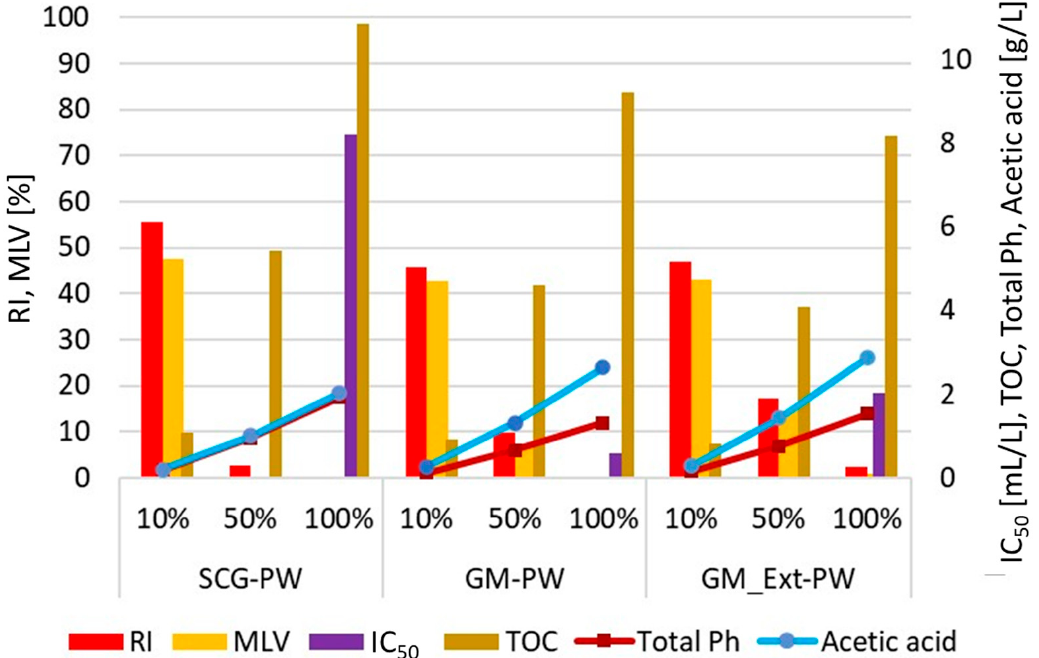
Figure 7. Characteristics of germination tests using process water. Acetic acid and Total phenols (Total Ph) are given in lines and Inhibition dose (IC 50 ), Total organic carbon (TOC), Root length index (RI), and Munoo-Liisa Vitality index (MLV) in bars.